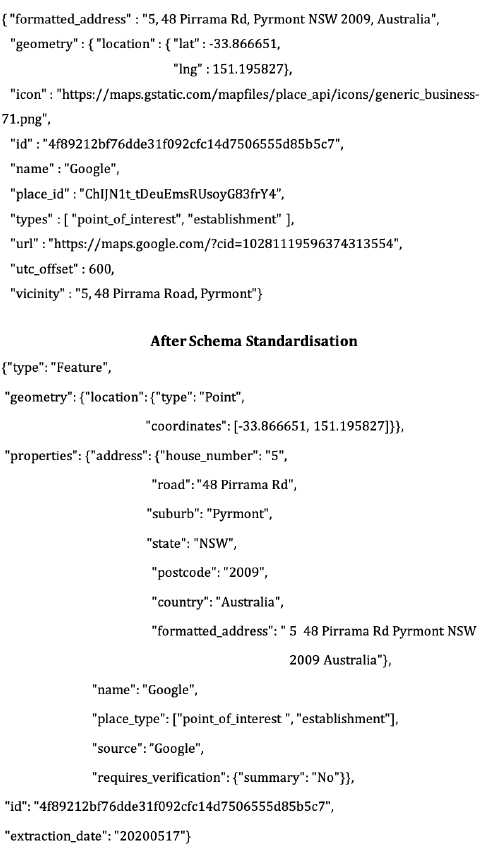
Figure 4. An example POI from Google Places before and after the schema standardisation step. A dummy example is provided for